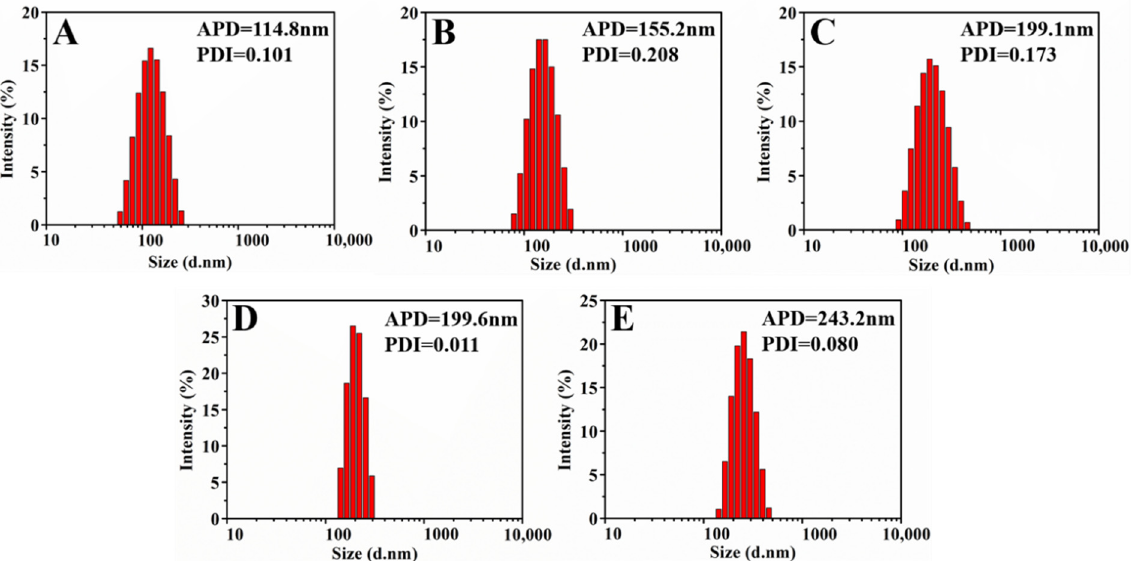
Figure 7. The average particle size distributions of MFWPU ( A ) and P(CTFE- alt -IBVE)/MFWPU composite particles prepared with MFWPU versus IBVE mass feed ratios of 1:1 ( B ), 1:3 ( C ), 1:4 ( D ) and 1:5 ( E ).